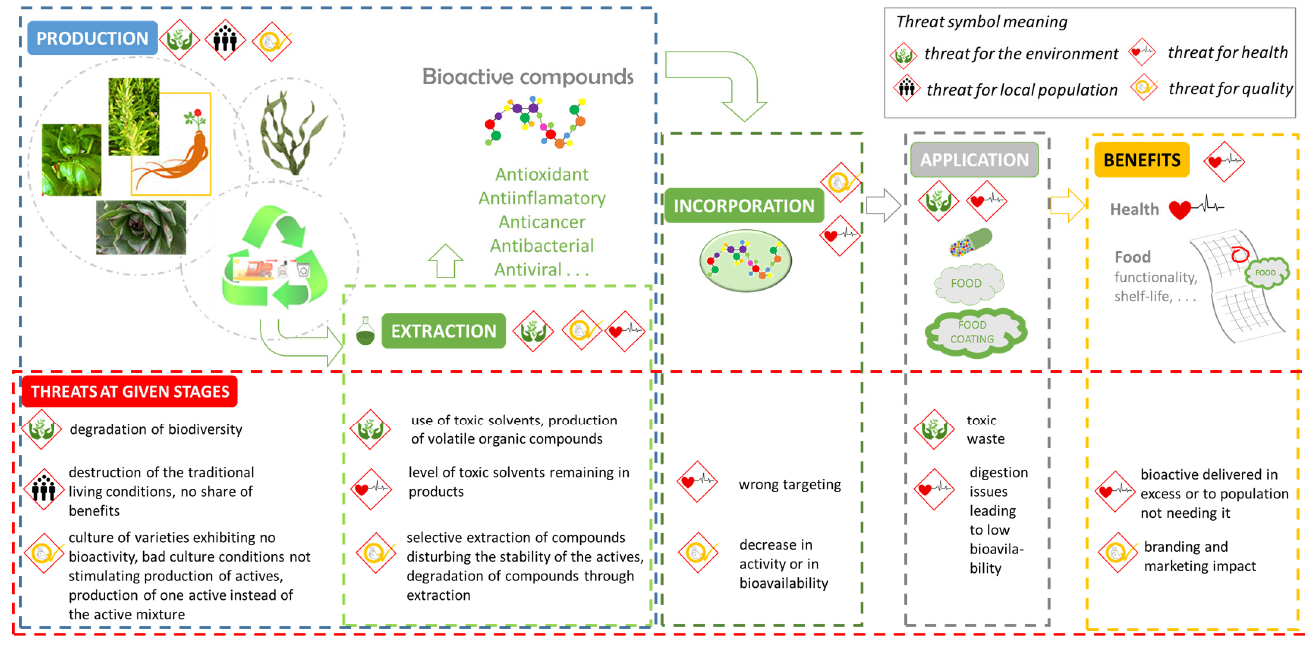
Figure 1. From raw material to the meeting of consumers’